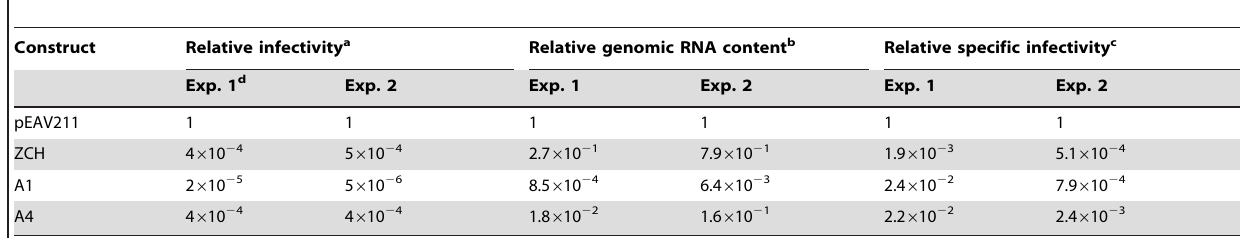
Table 2. Relative specific infectivities of virus particles from nsp1 mutants with imbalanced mRNA profiles.